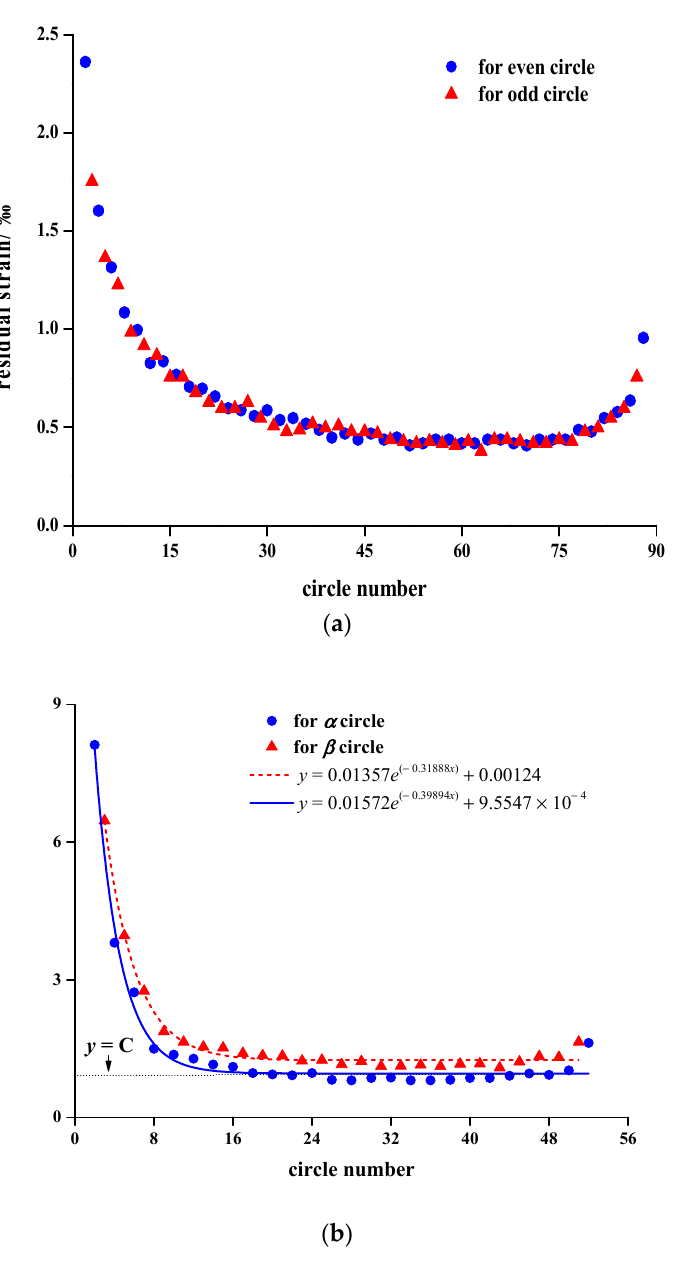
Figure 6. Residual axial strain for each loading circle for ( a ) the classic fatigue experiment and ( b ) the control group experiment with a time interval of 5 s.